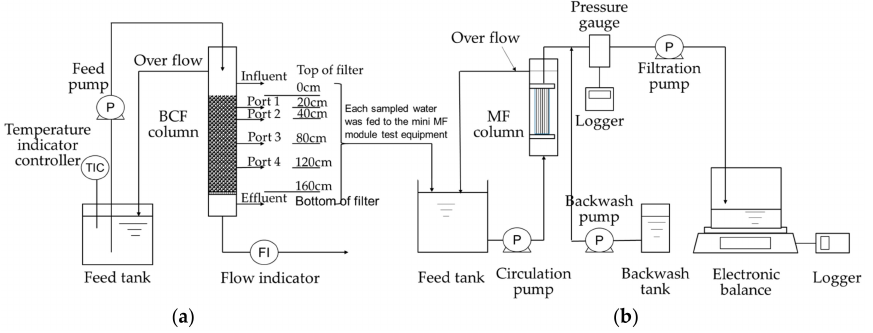
Figure 1. Schematic drawing of the test equipment employed in this study. ( a ) Mini biological contact filter (BCF) column; ( b ) Mini Microfiltration (MF)